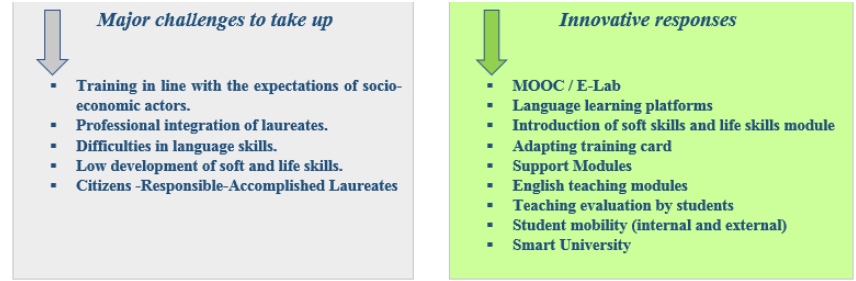
Fig. 7. Introduction of soft skills